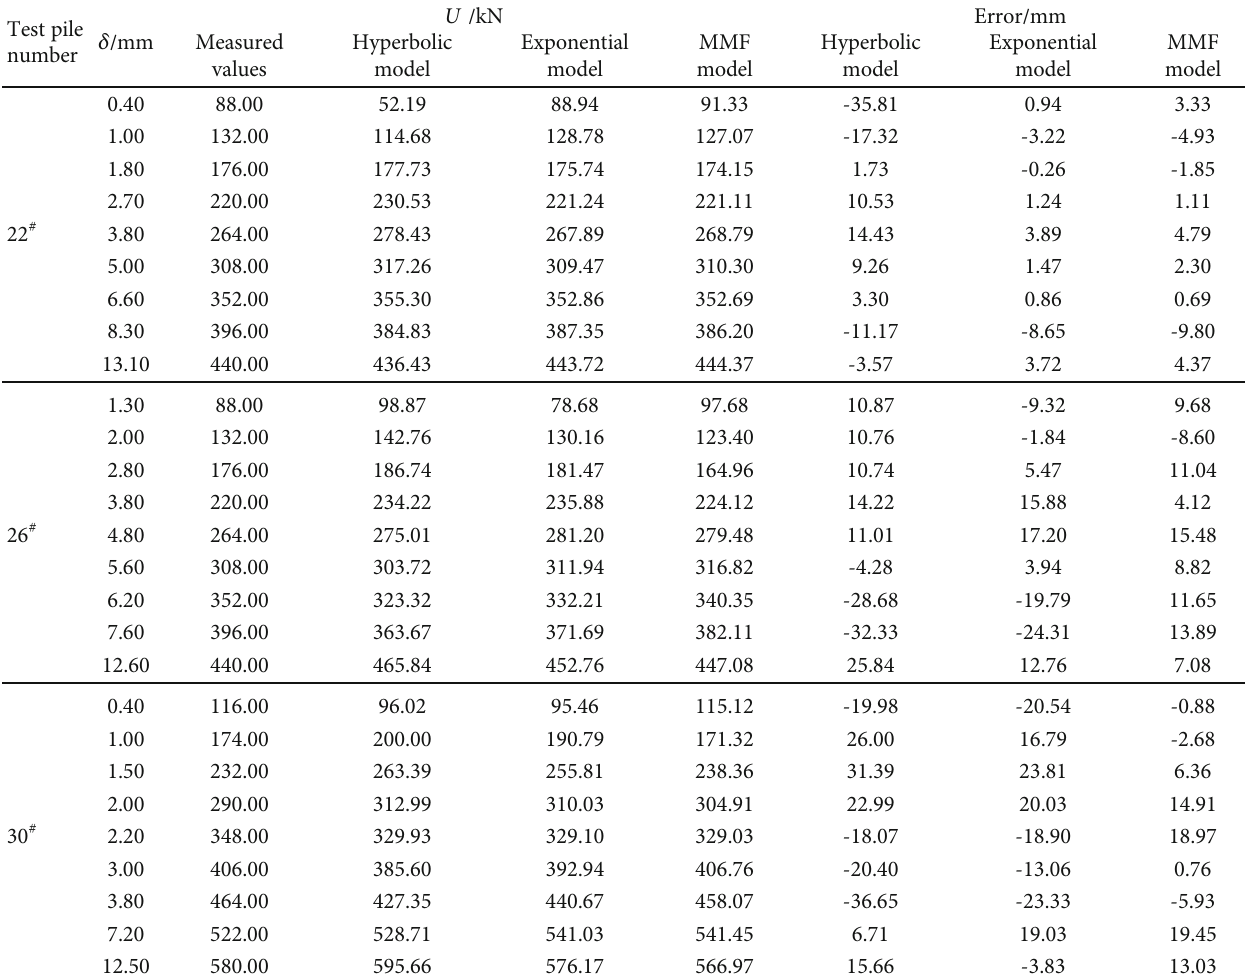
Table 3: Comparison of the fi tting e ff ect.